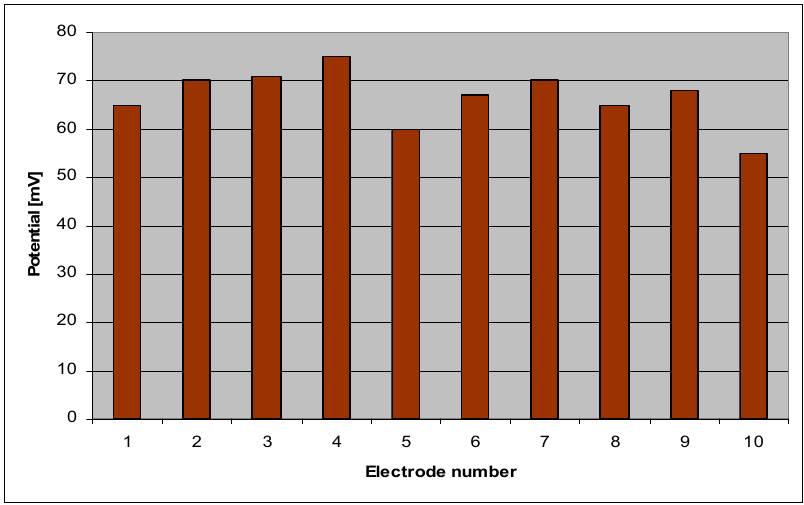
Figure 9. Potential of the 10 electrodes in pH 7.4 buffer